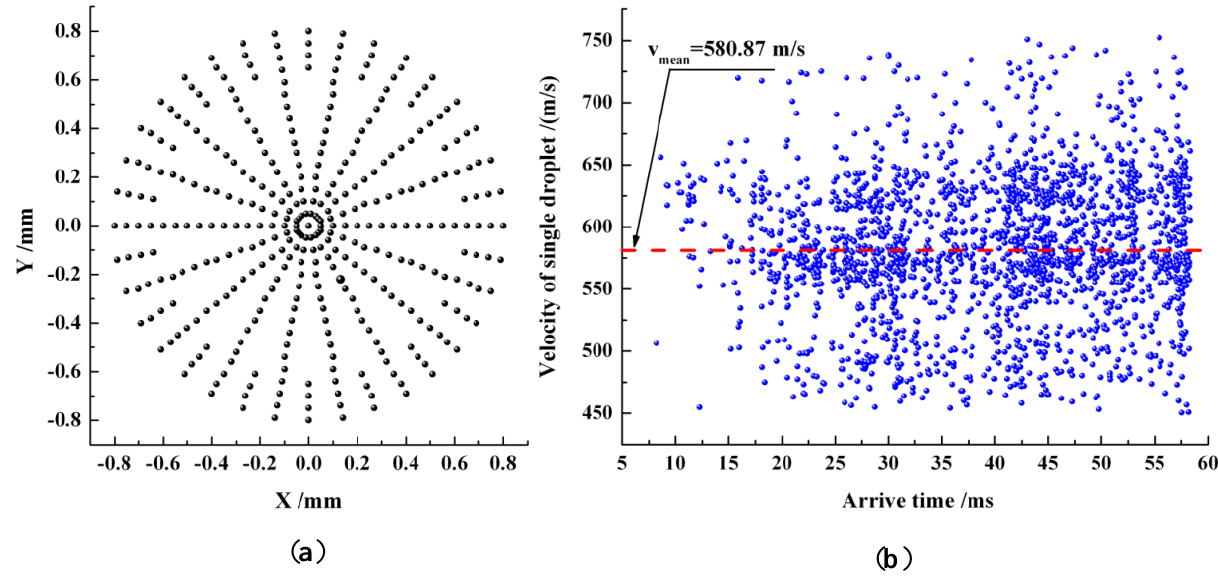
Figure 3. Arrangement and validation of measurement volume. ( a ) Positions of measurement volumes on a studied section; ( b ) distribution of the velocities of those droplets passing through the measurement volume deployed at the center of Z = 3.0 mm section within 57